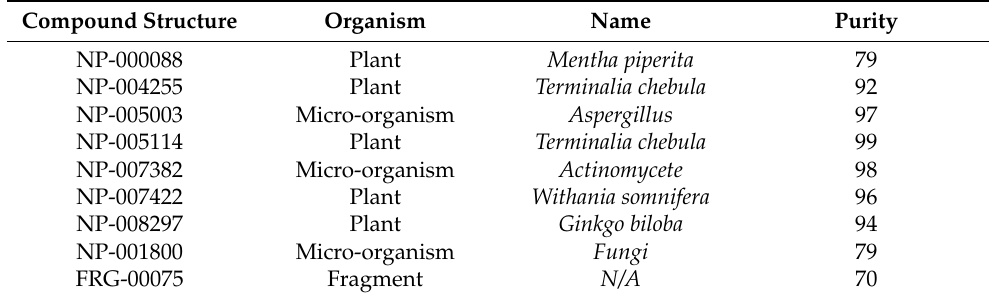
Table 4. The origin and sources of the test compounds. Purity data are as provided by the manufacturer. Compound